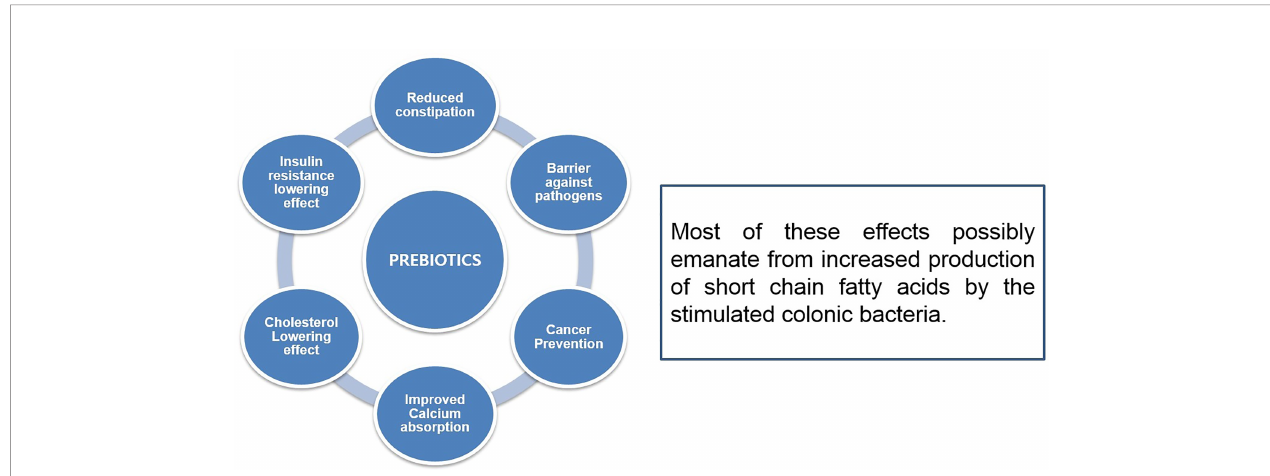
FIGURE 4 | Ef fi cacy of prebiotics and different types of functional